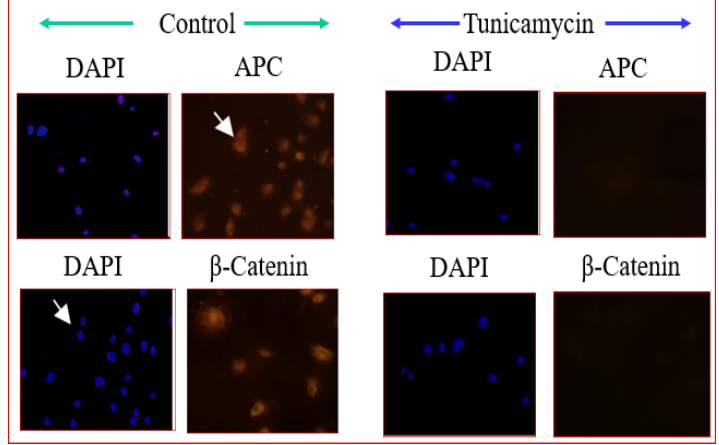
Figure 4. Immunofluorescence microscopy of Wnt proteins: The capillary endothelial cells were cultured for 24 h and synchronized for 72 h. The cells were treated with or without Tunicamycin (1 µ g/mL) for 32 h, fixed with 90% ice-cold methanol for 30 s, permeabilized with Triton ™ X-100 for 10 min, washed with PBS, pH 7.4 3 times, blocked with 3% BSA in PBS, pH 7.4 for 30 min, treated with anti- β -catenin, and anti-APC antibodies (1:50; v / v ) overnight followed by Rhodamin-conjugated rabbit anti-mouse IgG (red) secondary antibody (1:100; v / v ) before collecting the images in a Zeiss Axioskop 2. The nucleus was stained with Hoechst dye (blue).